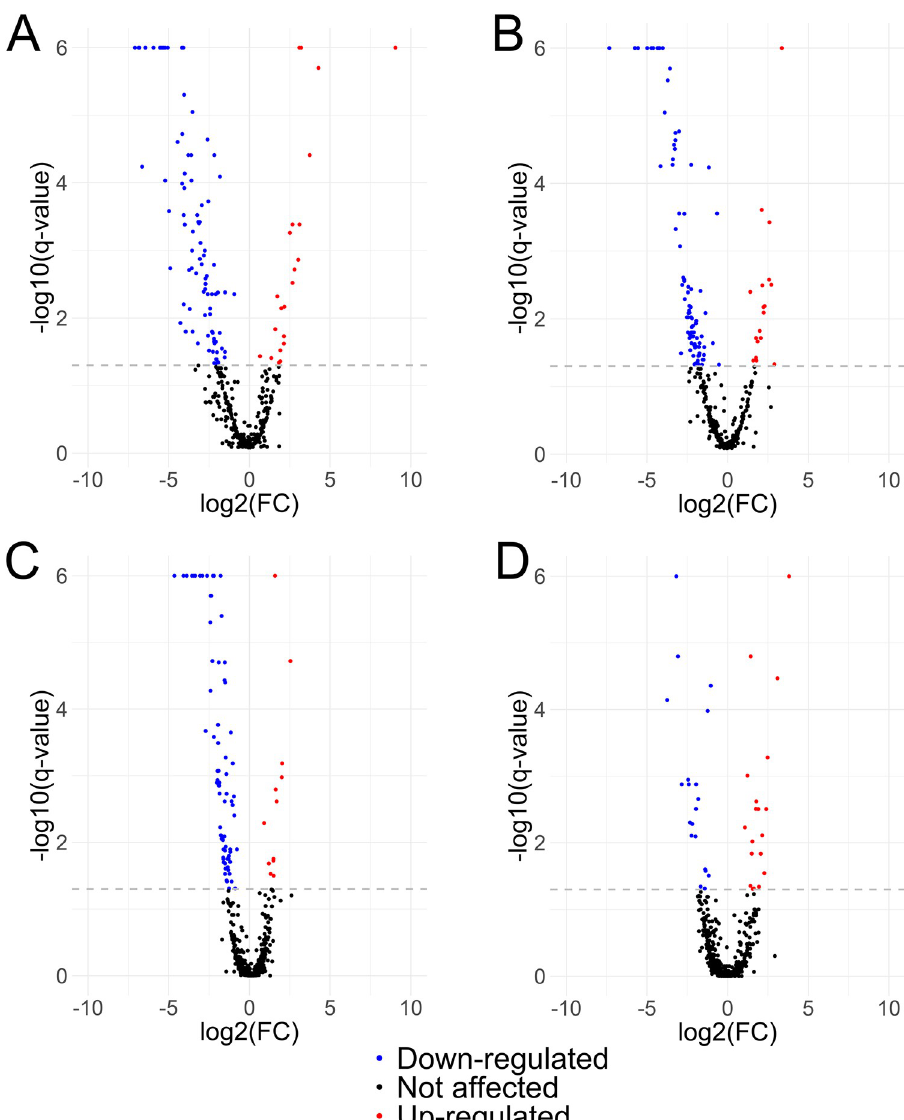
Fig 3. Volcano plots representing the changes in the proteomic profile of each group of samples analysed in the study. Volcano plots corresponding to FhNEJ detergent-soluble extract enriched with tegument (FhNEJ tegument; A), FhNEJ somatic (B), MPSIEC cytosol (C) and MPSIEC membrane (D) protein extracts. Red dots represent up- regulated proteins after stimulation challenge, and blue dots represent down-regulated proteins. Only DEPs with q- value < 0.05 were considered as differentially expressed, and no fold change threshold was